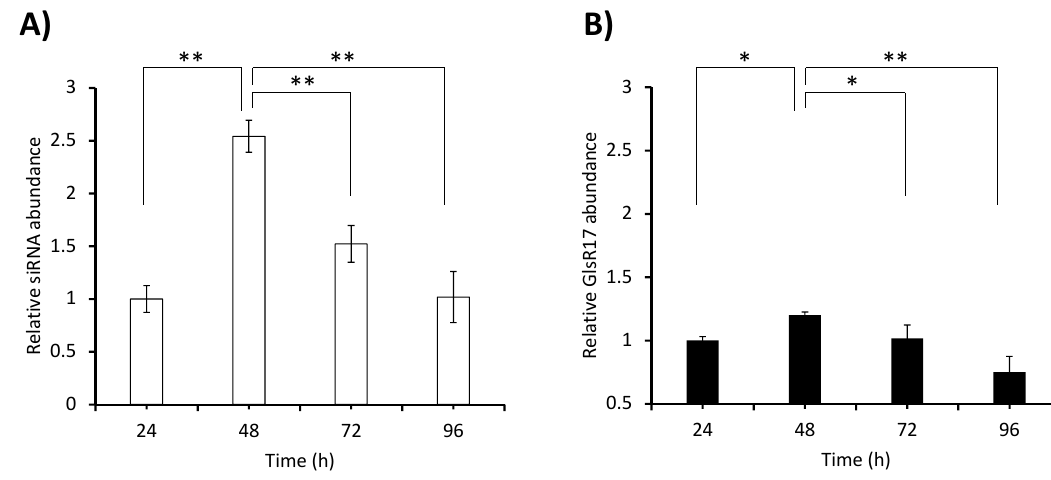
Figure 6. Quantification by RT-qPCR of siRNA ( A ) and snoRNA (GlsR17) ( B ) levels in trophozoites of the N200 transformant grown in TYI-S-33 medium. The error bars indicate standard deviation (SD) from five replicates. Statistical analysis by ANOVA and Tukey–Kramer test showed significant differences between 48 and 96 h of cultivation. A * p value < 0.05 and ** p value < 0.01 were considered statistically significant.